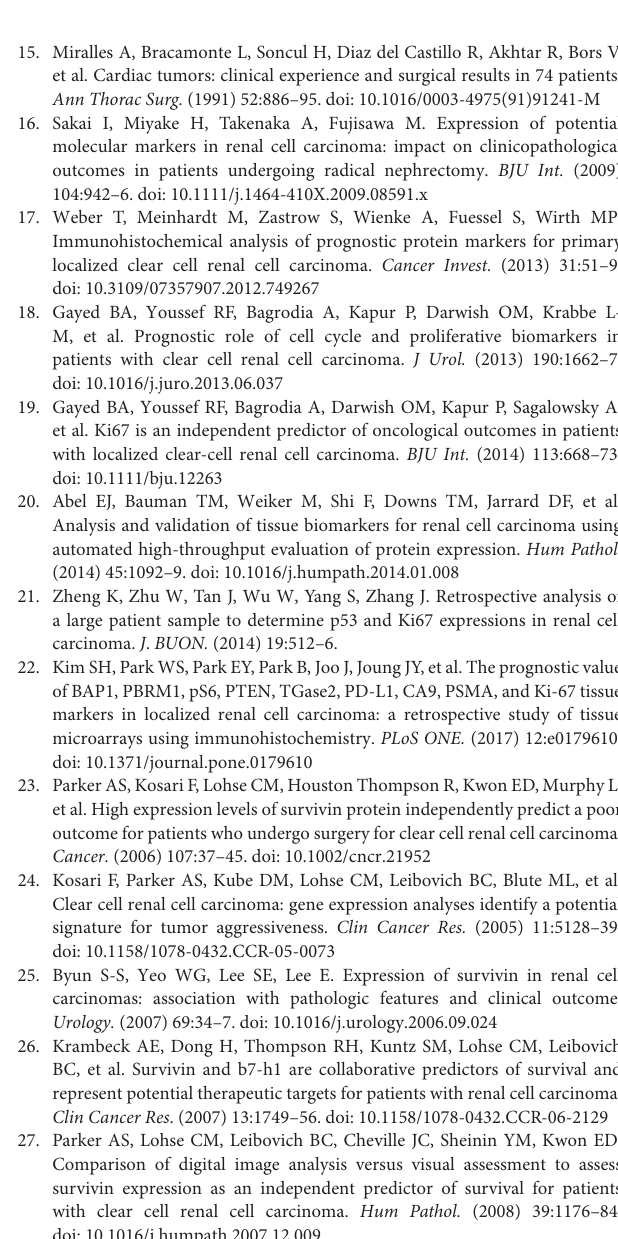
Supplementary Table 3 | Summary of the 13 multi-marker